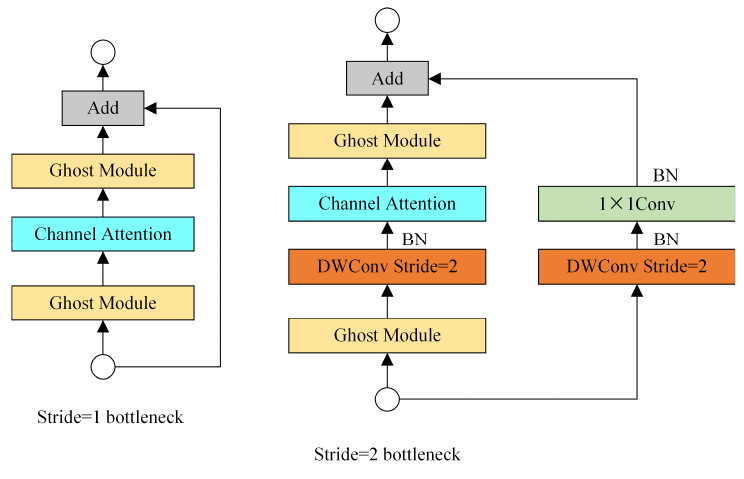
Figure 3. The structure of Ghost Bo tt